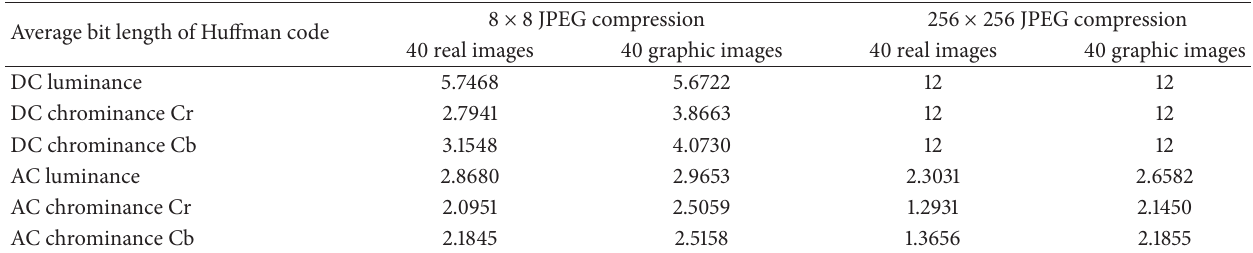
Table 4: Average bit length of Huffman code of image compression using 8 × 8 JPEG compression and 256 × 256 JPEG compression using psychovisual threshold for 40 real images and 40 graphical images.